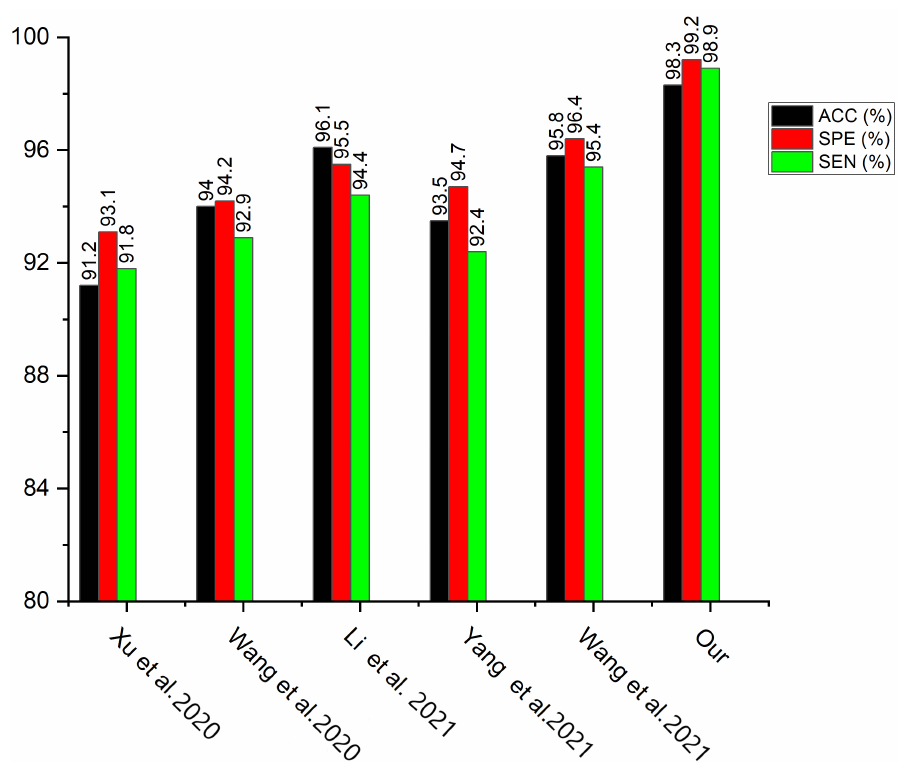
Figure 14. Performance evaluation for some selected state of the art models using the same